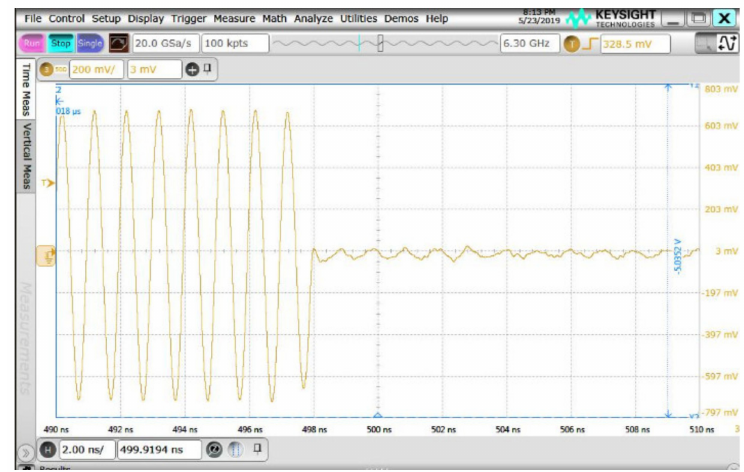
Figure 15. The falling edge of the switch during transition from ON state to OFF state.